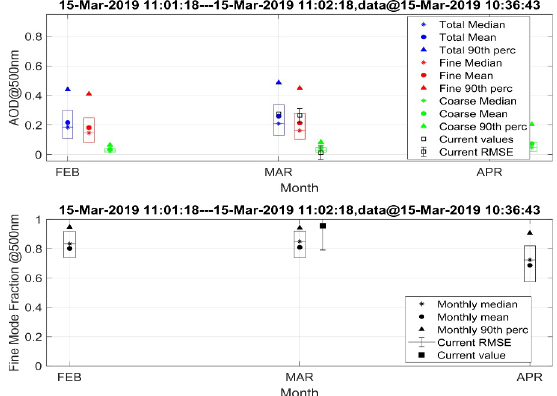
Fig. 2. AOD FMF and AOD CMF, FMF at